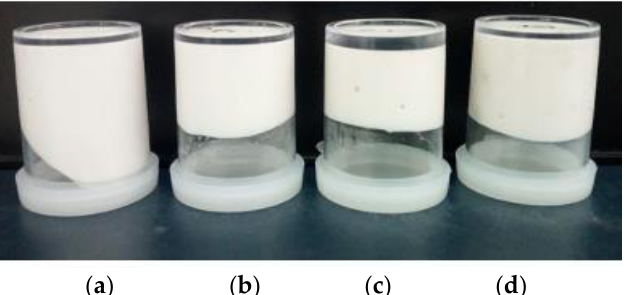
Figure 2. The visual appearance of EG with 20% of oils: ( a ) 0% of CMC (EG20-MS), ( b ) 0.5% of CMC (EG20-MS0.5), ( c ) 1.0% of CMC (EG20-MS1.0) and ( d ) 1.5% of CMC (EG20-MS1.5).